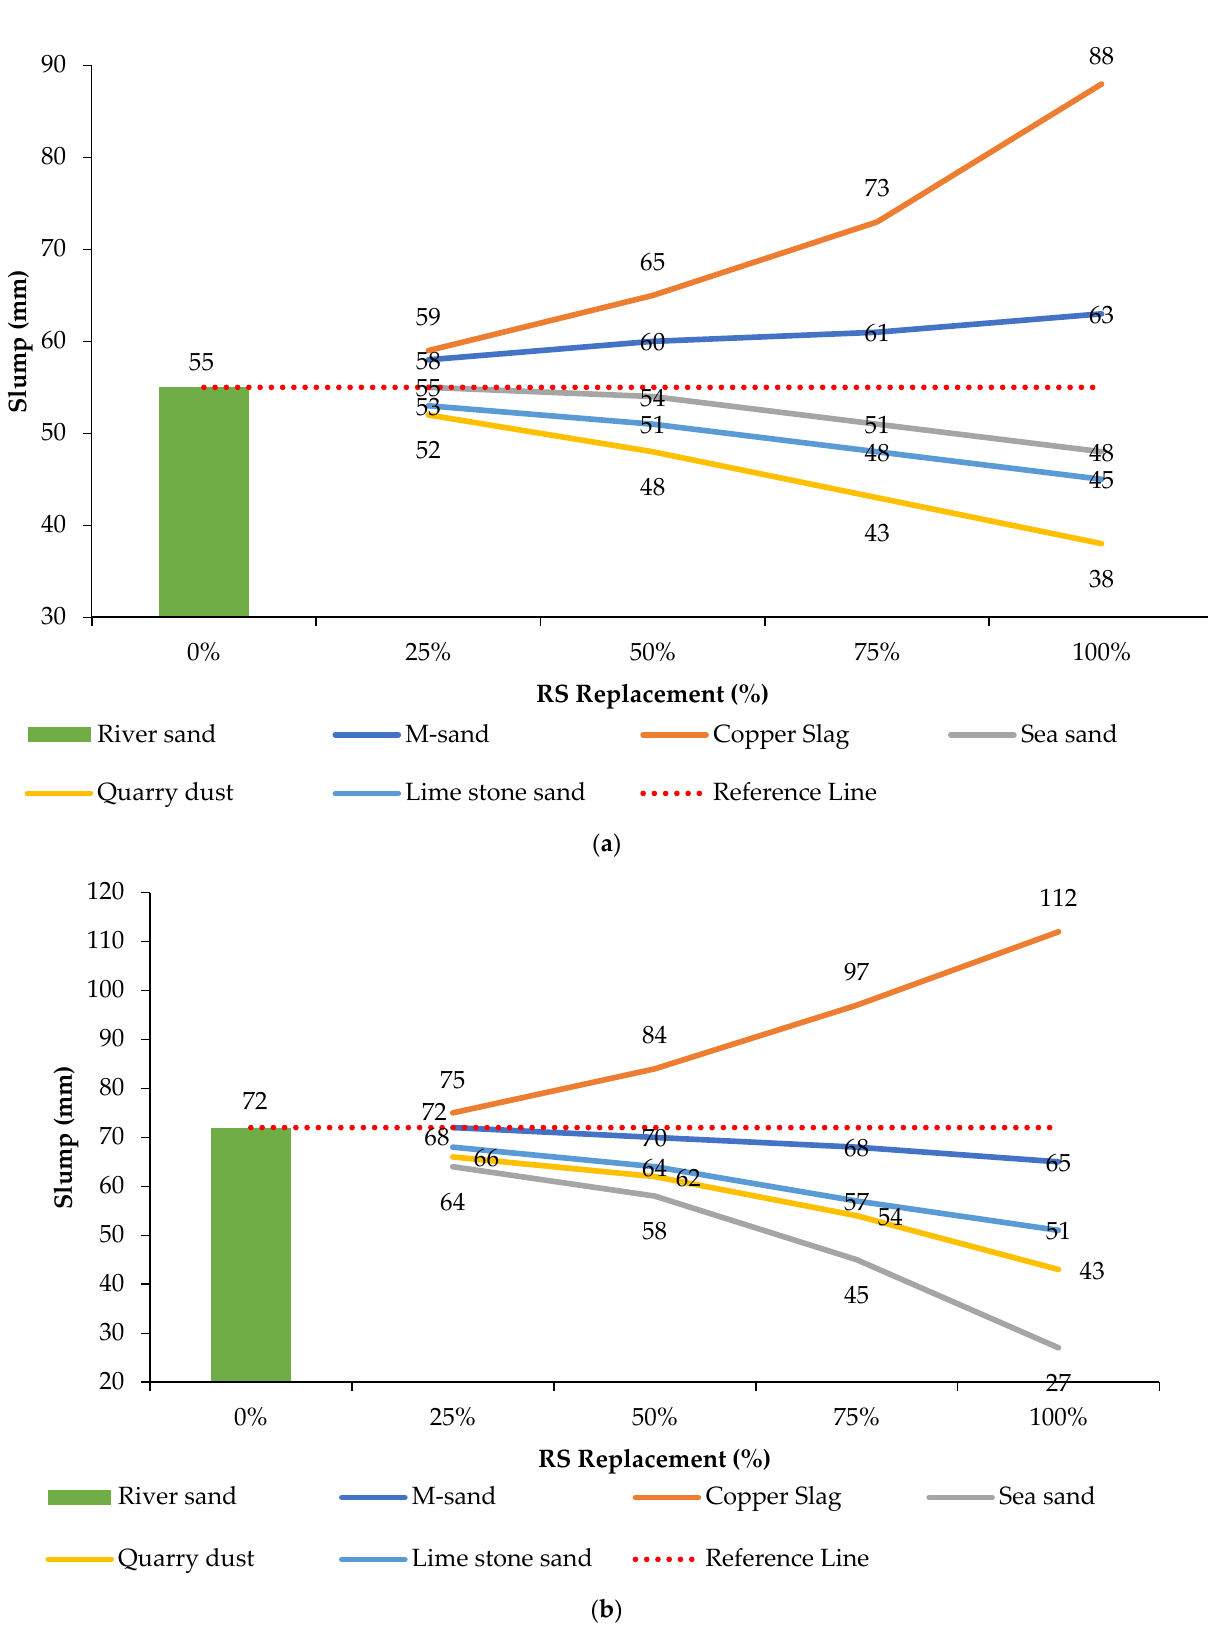
Figure 4. ( a ) The GPC — Slump value with respect to percentage of river sand replacement. ( b ) The CC — Slump value with respect to the percentage of river sand replacement.